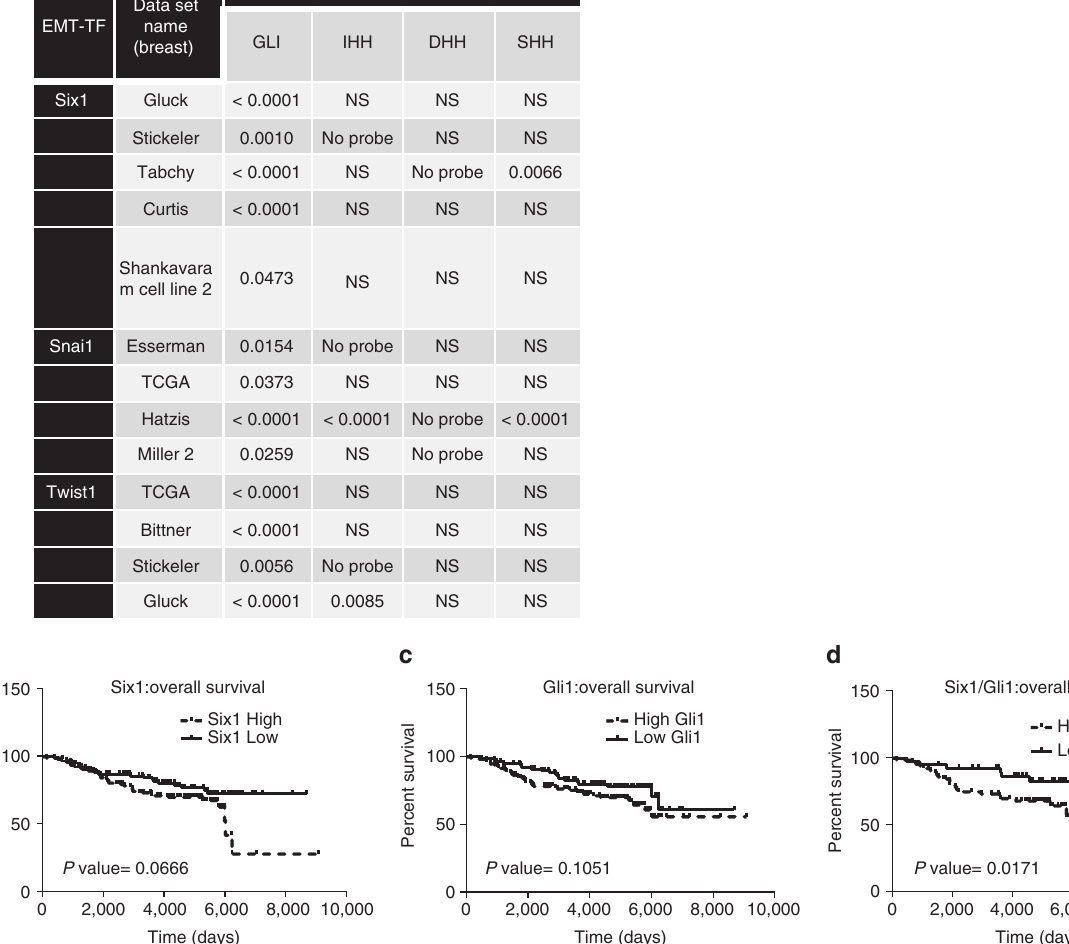
Figure 7 | Expression of GLI1 and EMT-TFs positively correlate in human patients. ( a ) Table demonstrating positive correlation between GLI1 mRNA and Six1 , Snai1 and Twist1 , but not between EMT-TF mRNA and Hh ligand mRNA, in multiple breast cancer datasets. Data obtained from Oncomine. ( b – d ) High levels of both GLI1 and Six1 together significantly correlate with worsened prognosis; data obtained from